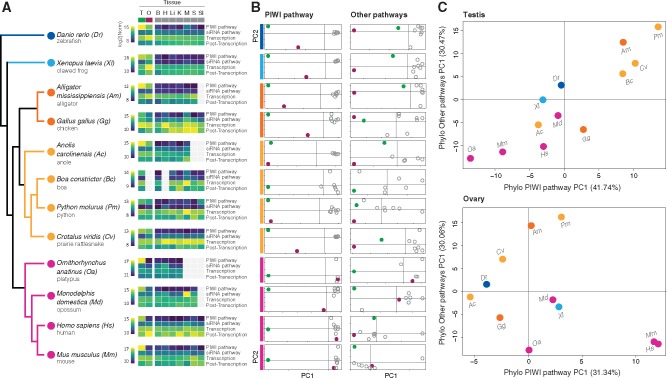
—Expression patterns of key genes involved in negative regulation of TE activity in germline and somatic vertebrate tissues. (A) For each species, heatmaps show log 2-transformed within-species normalized expression levels of main pathways involved in TE silencing. Warm colors (yellow) represent higher total expression levels of genes in the pathway across tissues. (B) PCAs for the PIWI:piRNA pathway (left) and all other regulatory pathways (siRNA pathway, transcriptional and posttranscriptional TE silencing mechanisms; right) reflect variance in gene expression profiles across tissues for each species. Although nonmammal species show discrimination of both germline tissues (testis in green and ovary in maroon) from somatic tissues (empty gray circles) and from each other in respect to PIWI pathway genes, gene expression in the mammalian ovary falls within the variability of somatic tissues. (C) PCAs for the testis (above) and ovary (below) show species clustering based on the principal component of the PIWI pathway (x axis) and all other regulatory pathways (y axis). Per each species, coordinates were extracted from the corresponding PIC PCAs. Cold colors represent nonamniote vertebrates, warm colors reptiles, and magenta mammal species.